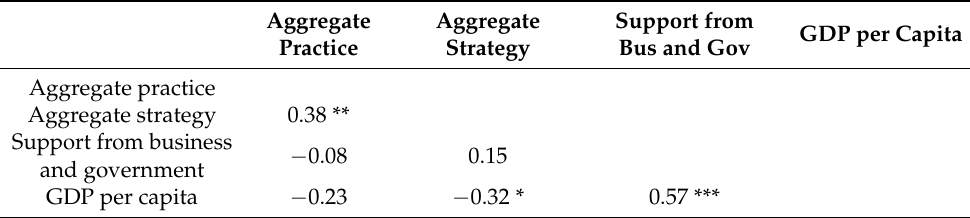
Table 3. Correlations among national-level variables of interest (N = 47 countries).